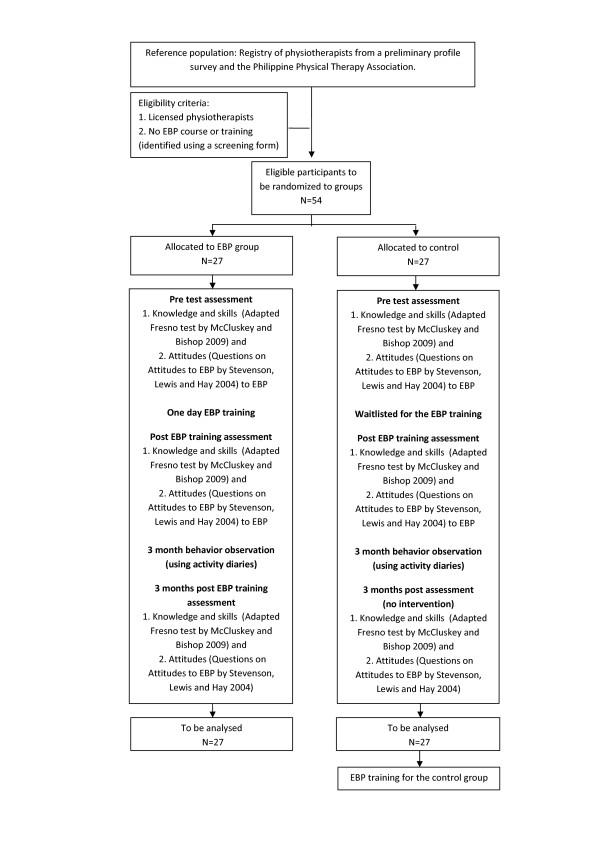
Flow of procedures.